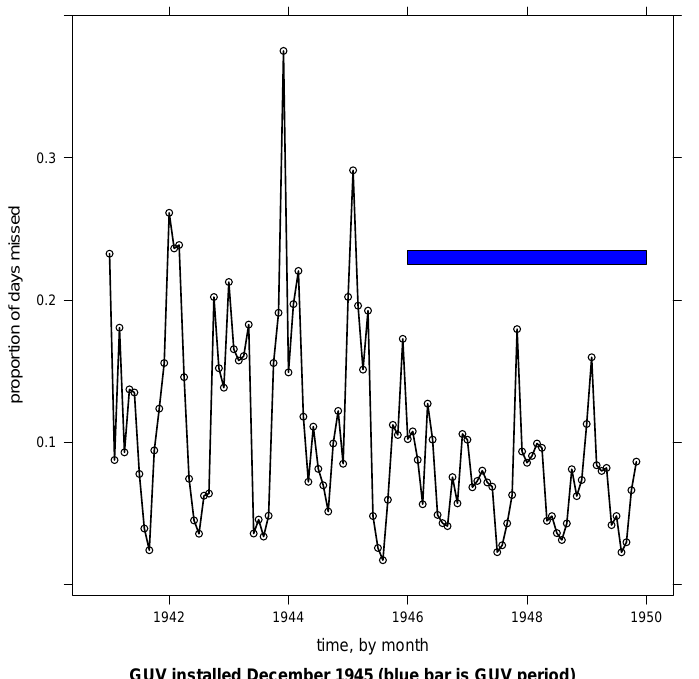
Figure 2. Monthly absenteeism rate for all age groups combined. The blue bar indicates the GUV